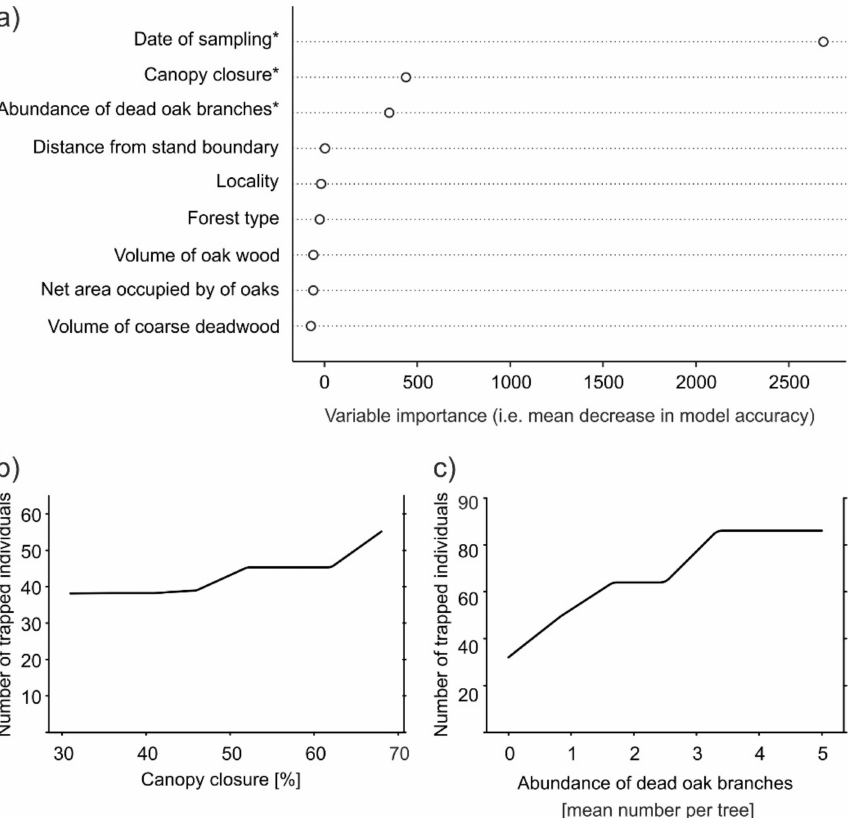
Figure 4. Results of random forest regression of number of ambrosia beetle individuals caught in traps as the response variable: ( a ) variable importance plot (based on the decrease of mean model accuracy with omission of the variable) showing the importance of particular variables for the number of ambrosia beetle individuals caught in the traps. Variables with a significant effect ( p < 0.05) are denoted with an asterisk (*); ( b , c ) partial dependence plots showing the marginal effect of selected significant explanatory variables on the mean number of ambrosia beetle individuals trapped during the eight 2-week periods from April to